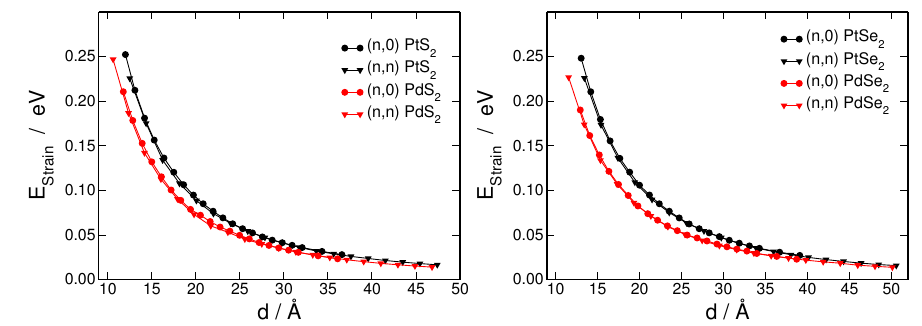
Figure 3. Strain energy vs. diameter of MX